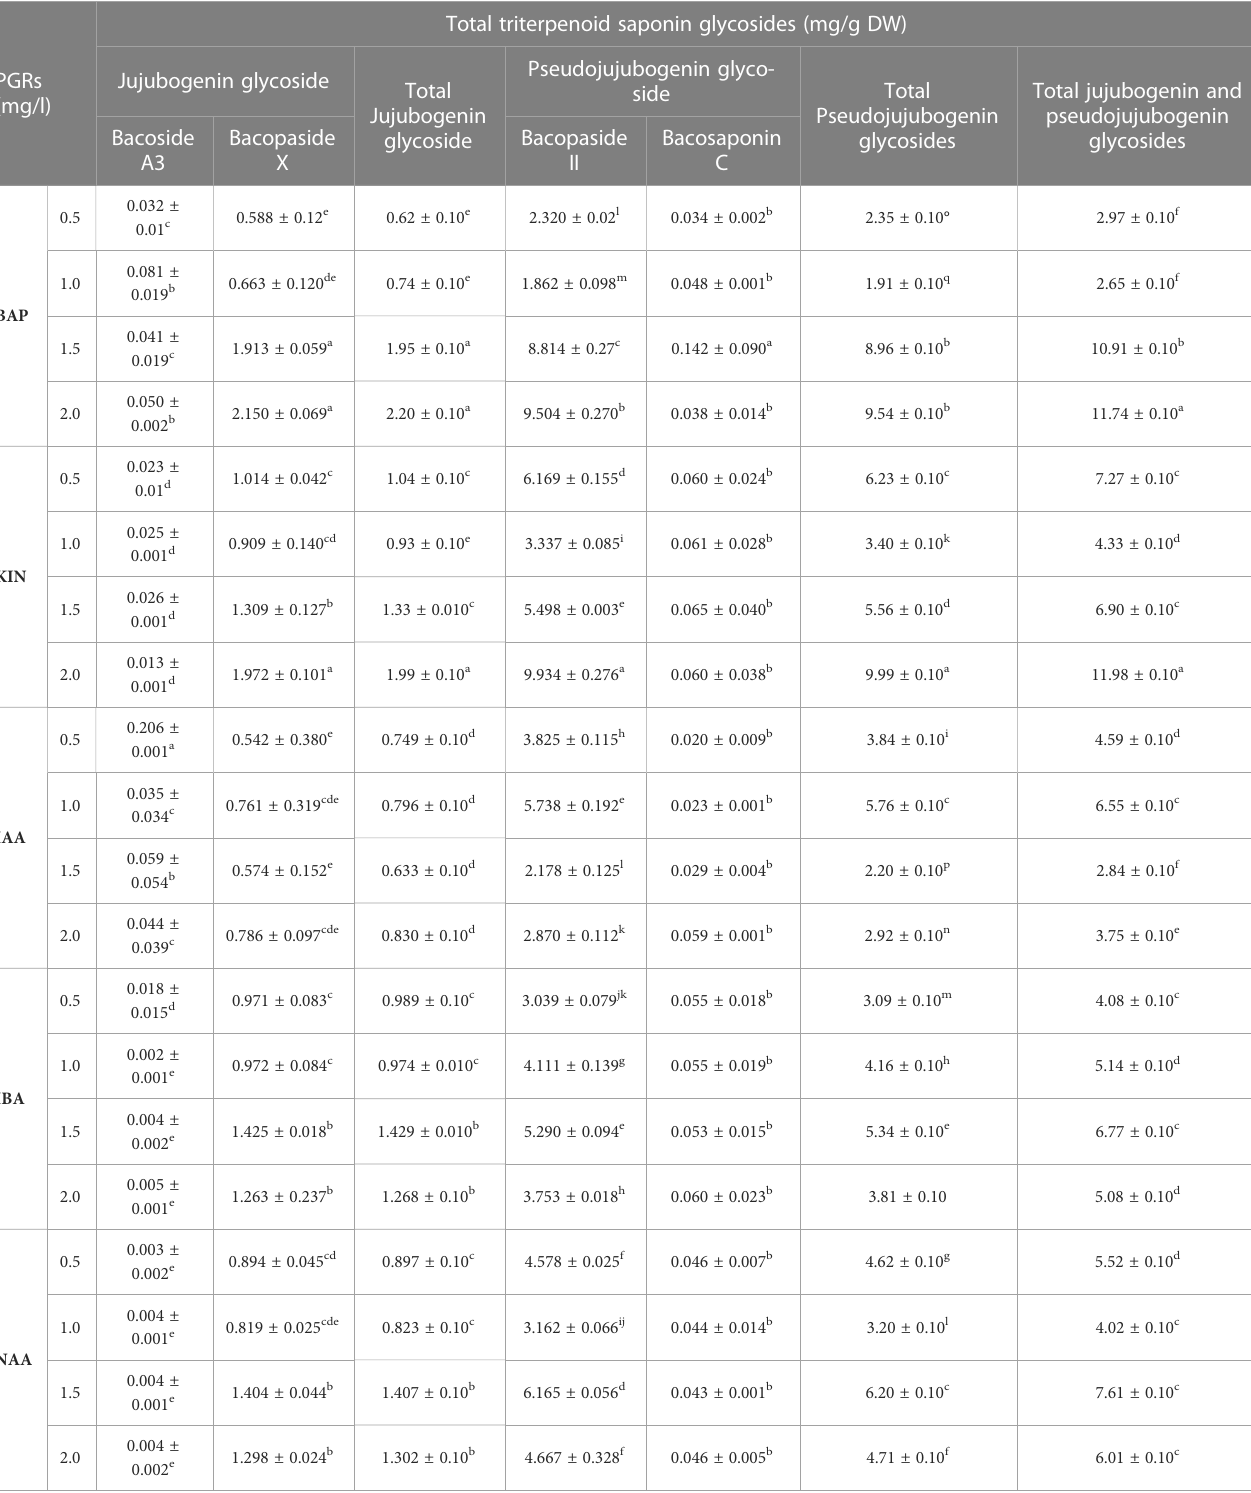
TABLE 5 Effects of different PGRs on total triterpenoid saponin glycosides (jujubogenin glycoside and pseudojujubogenin glycoside) from in vitro grown biomass of Bacopa fl oribunda .